Question: In one sentence, what is this figure communicating?
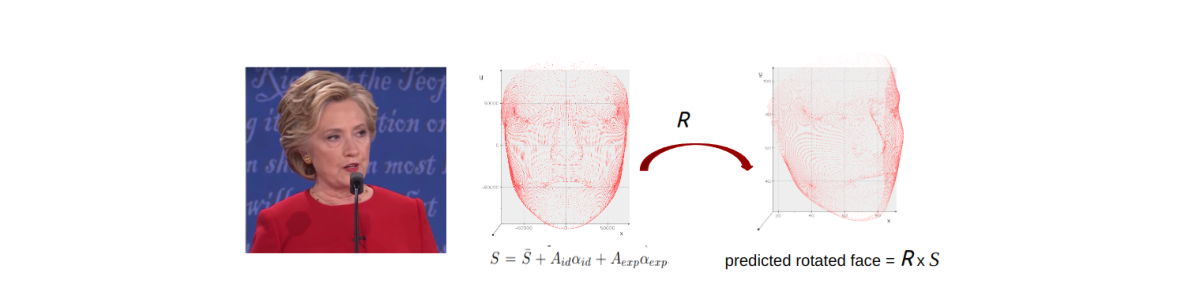
Answer: Non-scaled, non-transitional, rotated 3D Face by 3DDFA